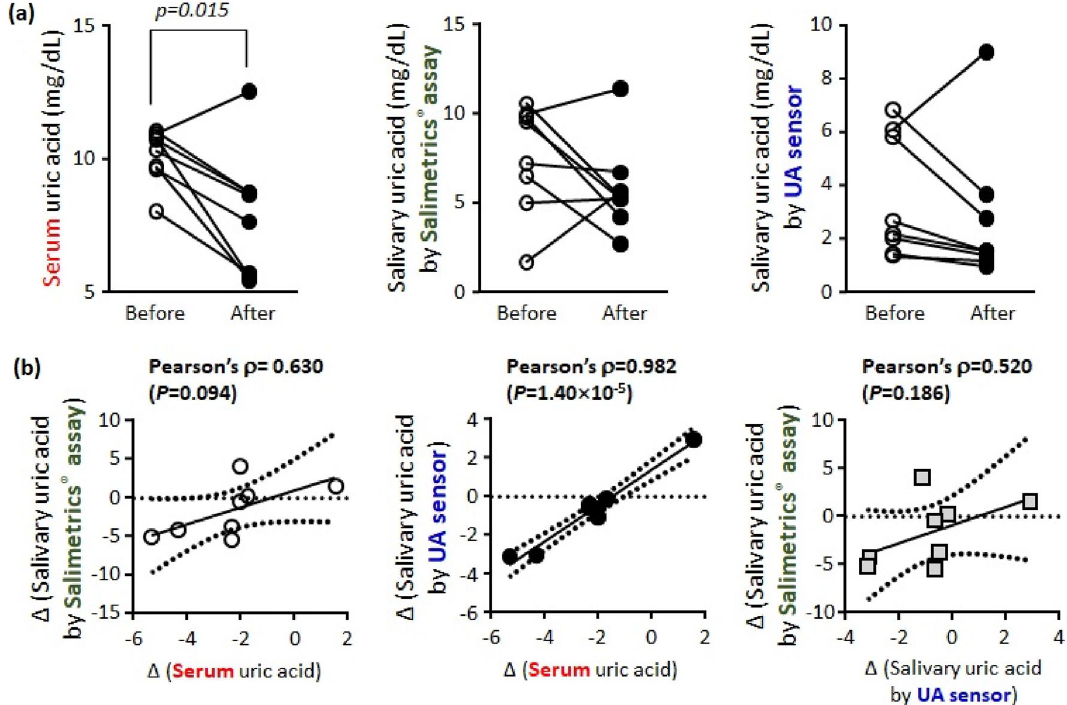
Figure 5. Change in uric acid (UA) levels in serum and unstimulated whole saliva samples after urate-lowering therapy. ( a ) In patients with gout (n = 8), serum UA levels decreased significantly after the treatment. However, salivary UA levels were not significantly changed regardless of the method used. ( b ) Changes in serum UA were significantly correlated with changes in salivary UA levels measured with our UA sensor ( p < 0.0001), but not Salimetrics®